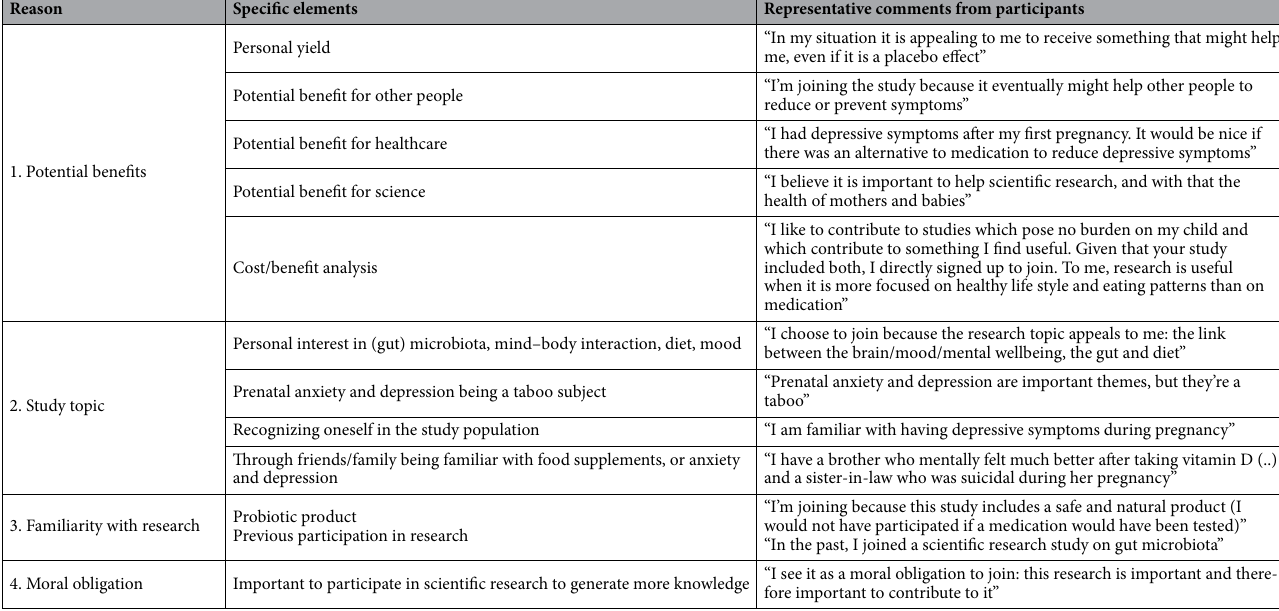
Table 5. Description of reasons for participation in the pilot trial.